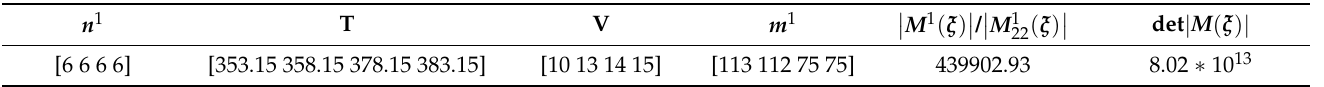
Table 18. Optimization results of the optimal scheme in Reference